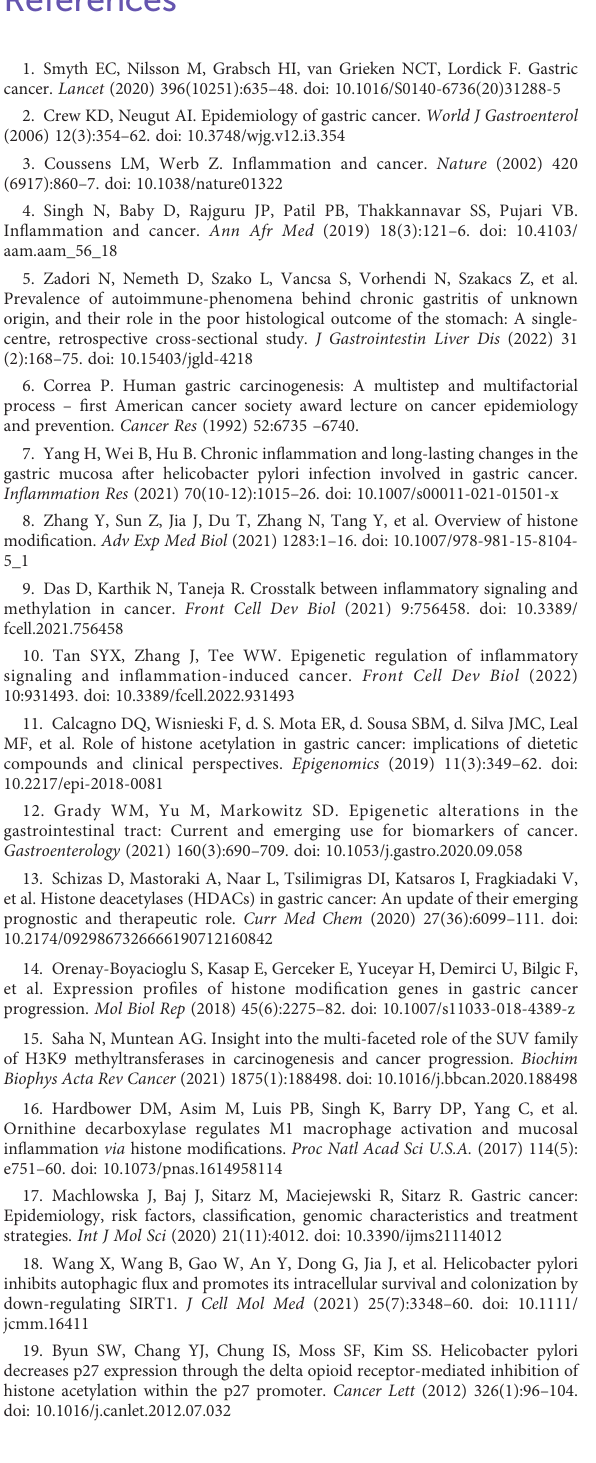
associations between HMGs and immune response. Figure S7 showed survival analysis predicting the relationship between SIRT6 expression and patient survival. Figure S8 showed dot plots showing top 9 genes negatively correlated with SIRT6 across all samples and